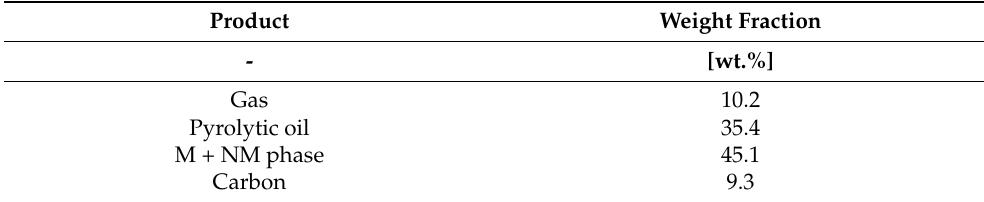
Table 14. Distribution of the pyrolysis products of NC2 fraction.